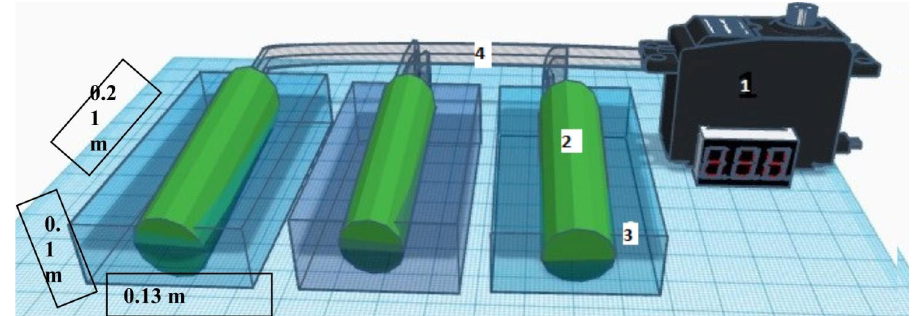
Fig. 2 Scheme of rotating biofilm photobioreactor. This device consists of (1) a motor. (2) Floating cylinders in culture medium (3) culture chamber con- taining the culture medium. (4)conveyor. The vessel size is 0.21 × 0.13 × 0.1 m 3 . 3 rotating cylinders horizontally are rotated in BBM medium each time. The chamber was 24 h continuously irradiated by two fluorescent